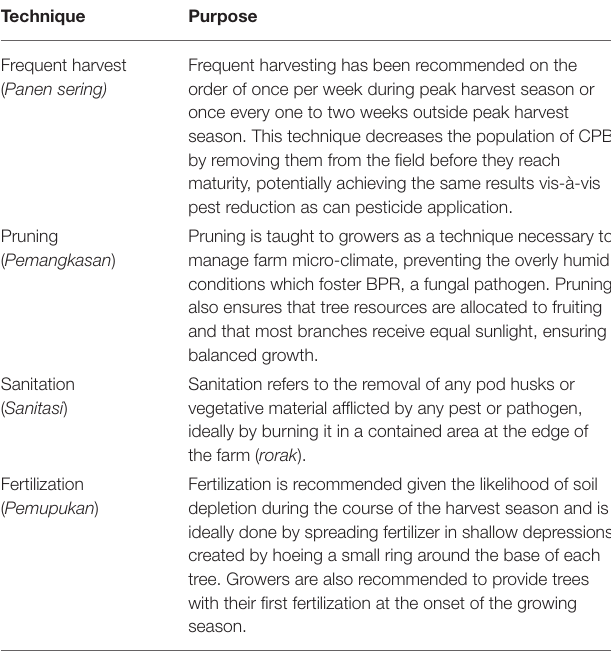
TABLE 2 | Overview of the PsPSP